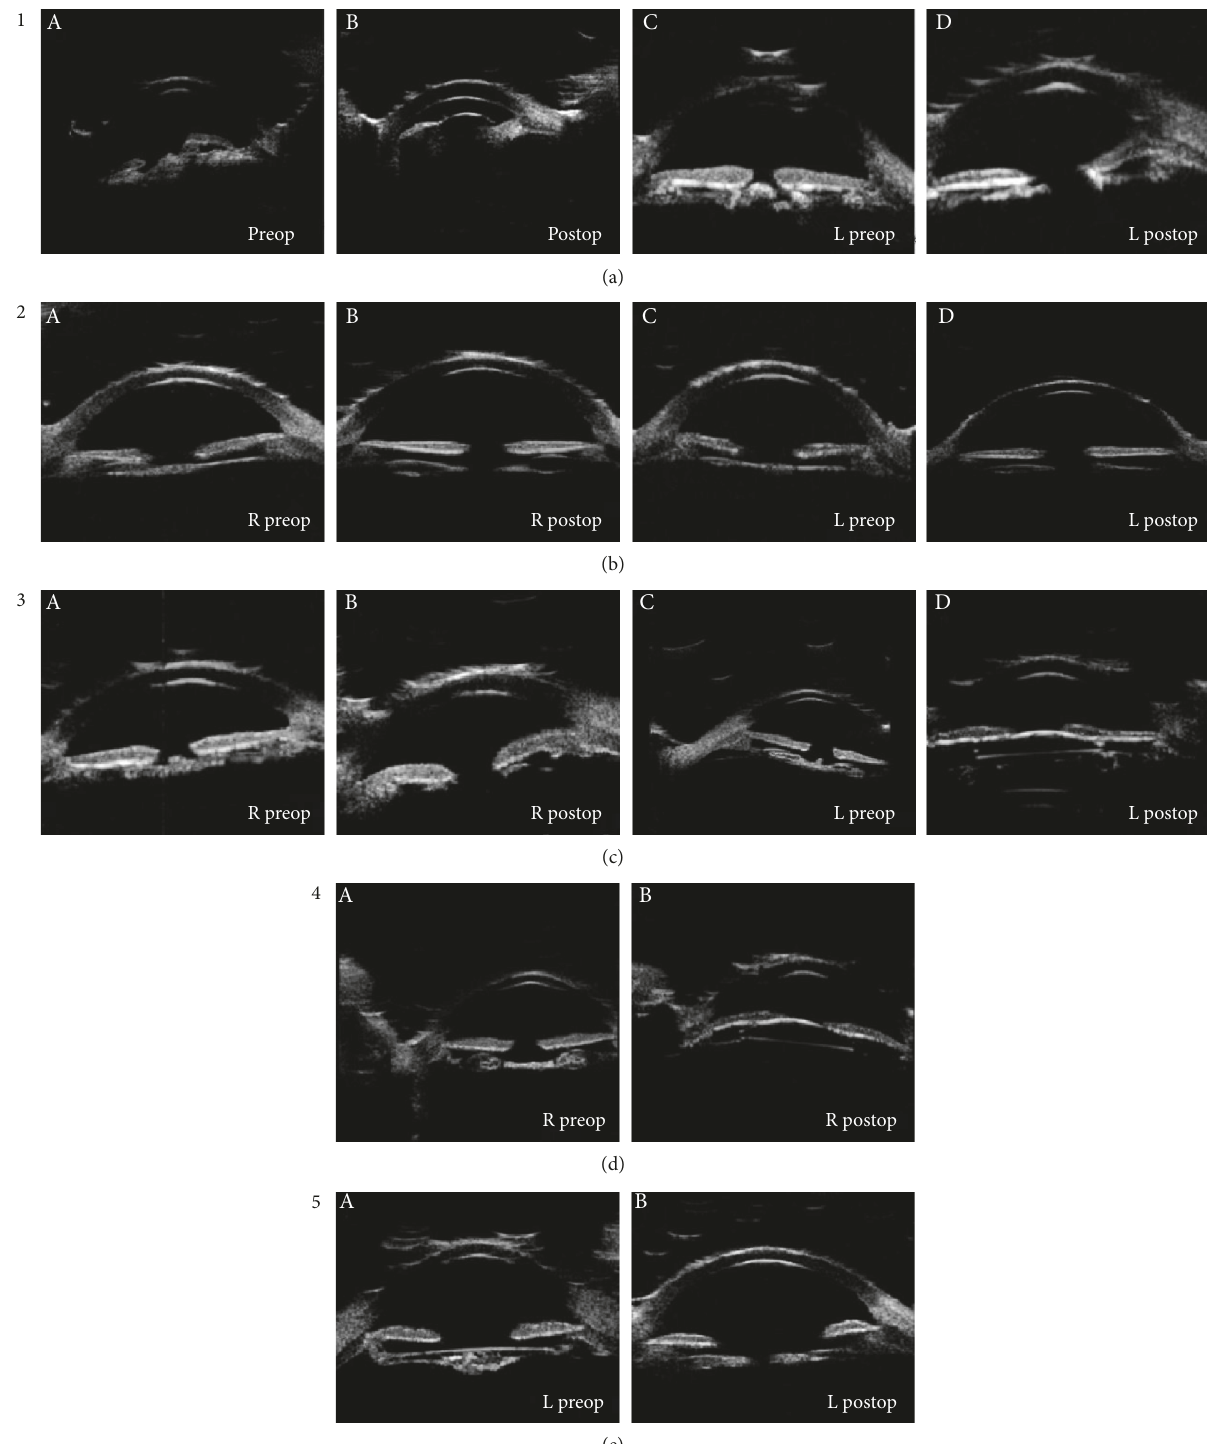
Figure 1: Ultrasound biomicroscopy images for di ff erent classi fi cations of cataract. UBM type 1 (a): (A, C) the anterior segment appeared as a thick high echoic area (like pizza) in the lens area (arrow). (B, D) An anechoic area in the central axis is visible after cataract surgery. A curved high echo in the shallow anterior chamber is visible (arrow: in fl ammatory membrane).UBM type 2 (b): (A, C) a linear high echo area in the lens of the anterior segment was seen (arrow). (B, D) An anechoic area in the central axis in the anterior segment was visible. UBM type 3 (c): (A, C) a high echoic area like a fl ying saucer was observed (arrow). (B, D) An anechoic area in the central axis was observed after the cataract surgery. UBM type 4 (d): (A) a high echoic area like a dumbbell was visible in the right eye. (B) A curved high echo in central axis after IOL implantation was visible. UBM type 5 (e): (A) A fusiform high echoic in the lens area was observed (arrow). (B) An anechoic area was observed along the central axis after cataract removal